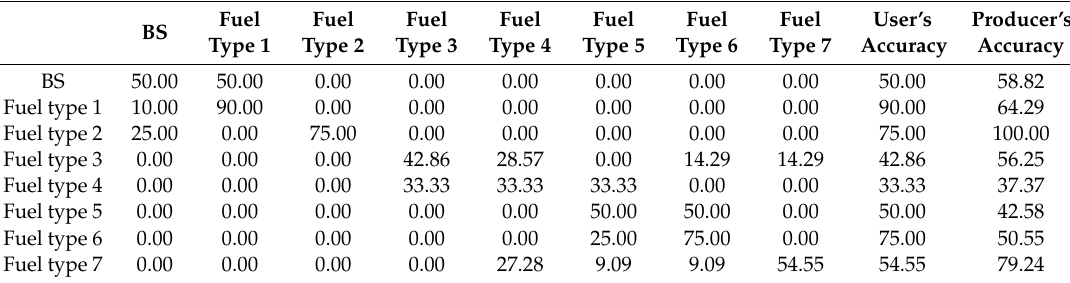
Table 6. Confusion matrix for the most accurate classification model combining ALS and Sentinel 2 data after validation. Values are showed in %. BS stands for bare